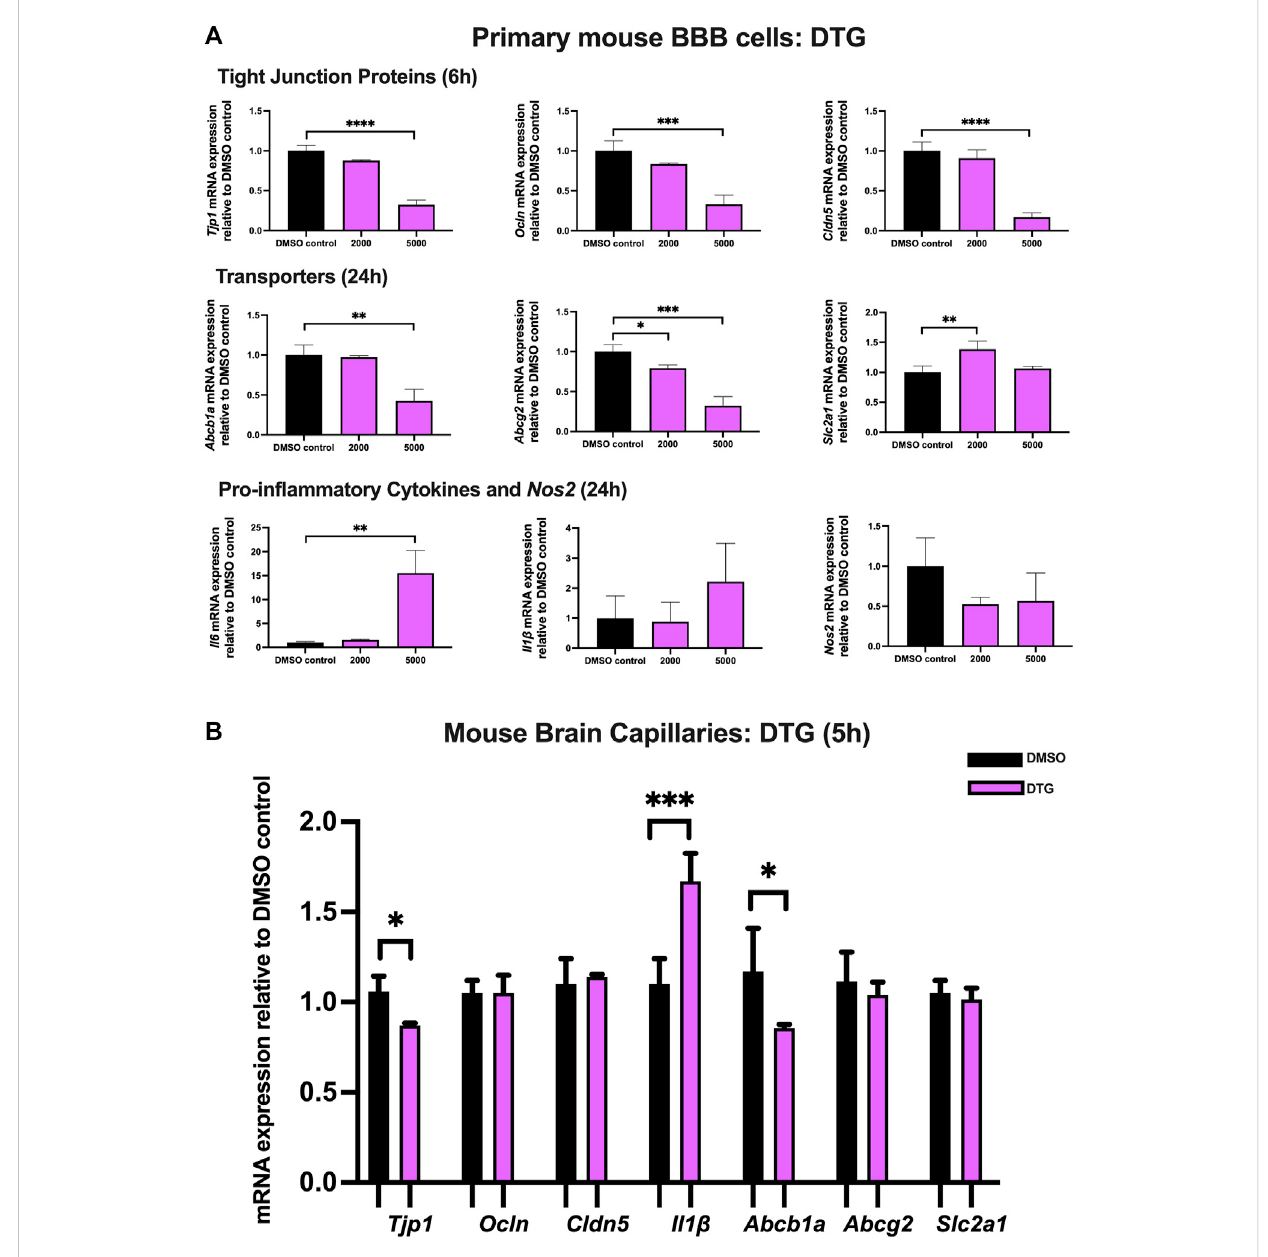
FIGURE 4 mRNA expression of TJ proteins, transporters, proin fl ammatory cytokines and Nos2 in primary cultures of mouse brain microvascular endothelial cells exposed to DTG (2000, 5,000 ng/mL) and vehicle (DMSO) control for 6 or 24 h and in isolated mouse brain capillaries exposed to DTG (5,000 ng/ mL) and vehicle (DMSO) control for 5 h (A) mRNA expression of Tjp1, Ocln, Cldn5, Abcb1a, Abcg2, Slc2a1, Il6, Il1 β and Nos2 in primary cultures of mouse brain microvascular endothelial cells exposed to DTG relative to vehicle (DMSO) control was assessed by qPCR. Results are presented as mean relative mRNA expression ±SEM normalized to the housekeeping mouse cyclophilin B gene from n = 4 independent experiments. (B) mRNA expression of Tjp1, Ocln, Cldn5, Abcb1a, Abcg2, Slc2a1 and Il1 β in isolated mouse brain capillaries treated for 5 h with DTG (5,000 ng/mL) relative to vehicle (DMSO) was assessed by qPCR. Results are presented as mean relative mRNA expression ±SEM normalized to the housekeeping mouse cyclophilin B gene from n = 3 independent experiments, where each experiment contained pooled brain tissues from 6 animals per group. One-way ANOVA with Bonferroni ’